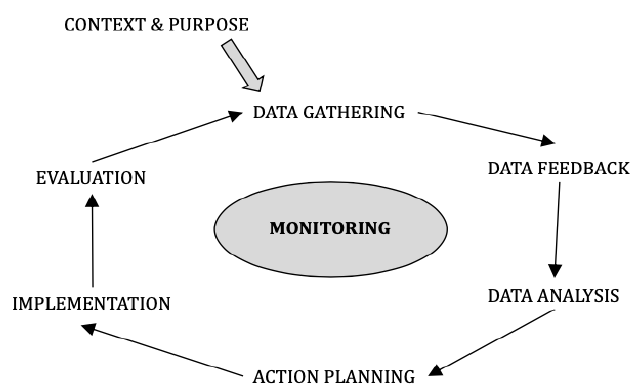
Figure 2. Action research cycle (Coughlan & Coghlan,